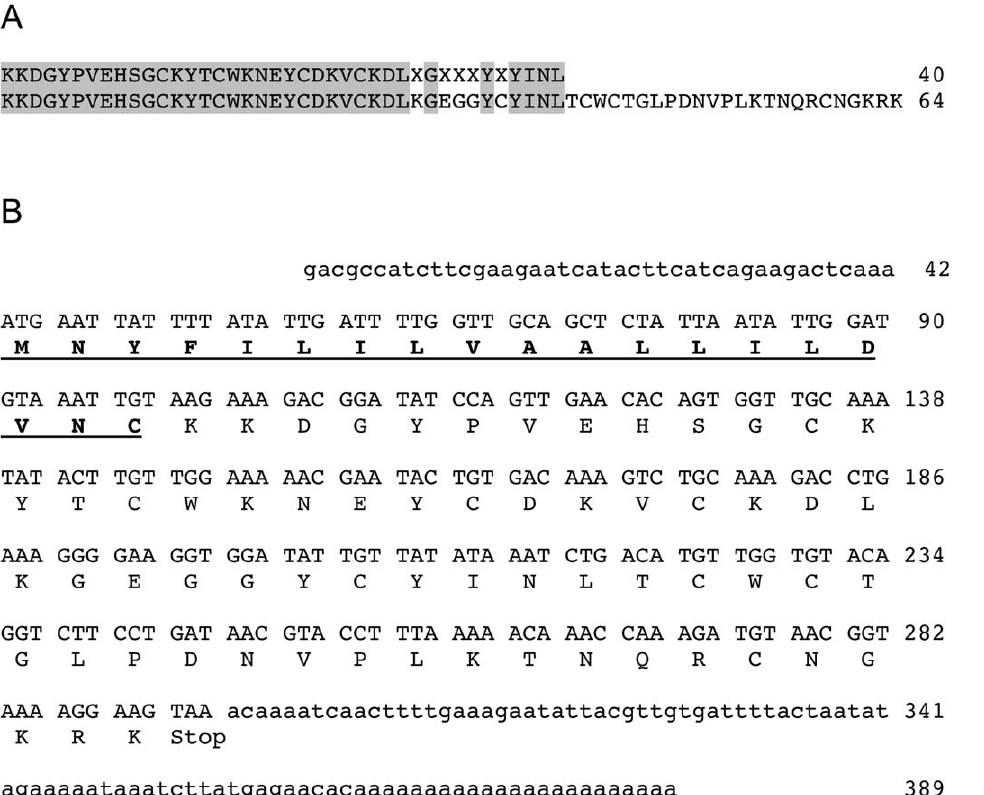
Figure 4. Amino acid sequence of subfraction P4-4 (CvIV4) and C. vittatus venom gland cDNA that encodes toxin CvIV4. A. Comparison of amino acid sequences representing CvIV4. The upper sequence represents the initial 40 amino acids of the purified peptide obtained from Edman degradation. Amino acid residues that could not be determined are shown as ‘‘X’’. The lower sequence represents the translation of nucleotides from the cDNA encoding CvIV4 isolated from C. vittatus venom gland. Sequences representing the peptide and translated gene are identical with the exception of the five amino acid residues (X’s) that could not be identified. B. Nucleotide sequence from venom gland cDNA that encodes toxin CvIV4. Nucleotide sequence from the 5 9 and 3 9 untranslated region (UTR) is shown as lower case letters. Sequence from the mature peptide is shown as upper case letters. Amino acid residues translated from nucleotide sequence are shown as upper case letters positioned below their corresponding codons. Amino acids designating the signal peptide are underlined and shown in